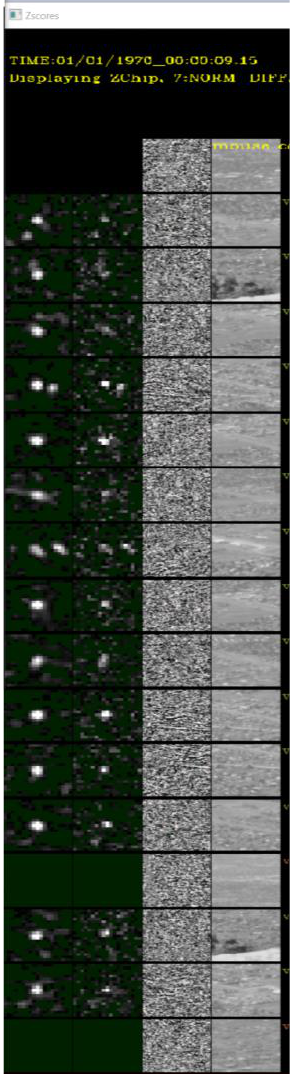
Figure 13. Chip Comparison of Detected Vehicle at Sandia Mountain Peak.